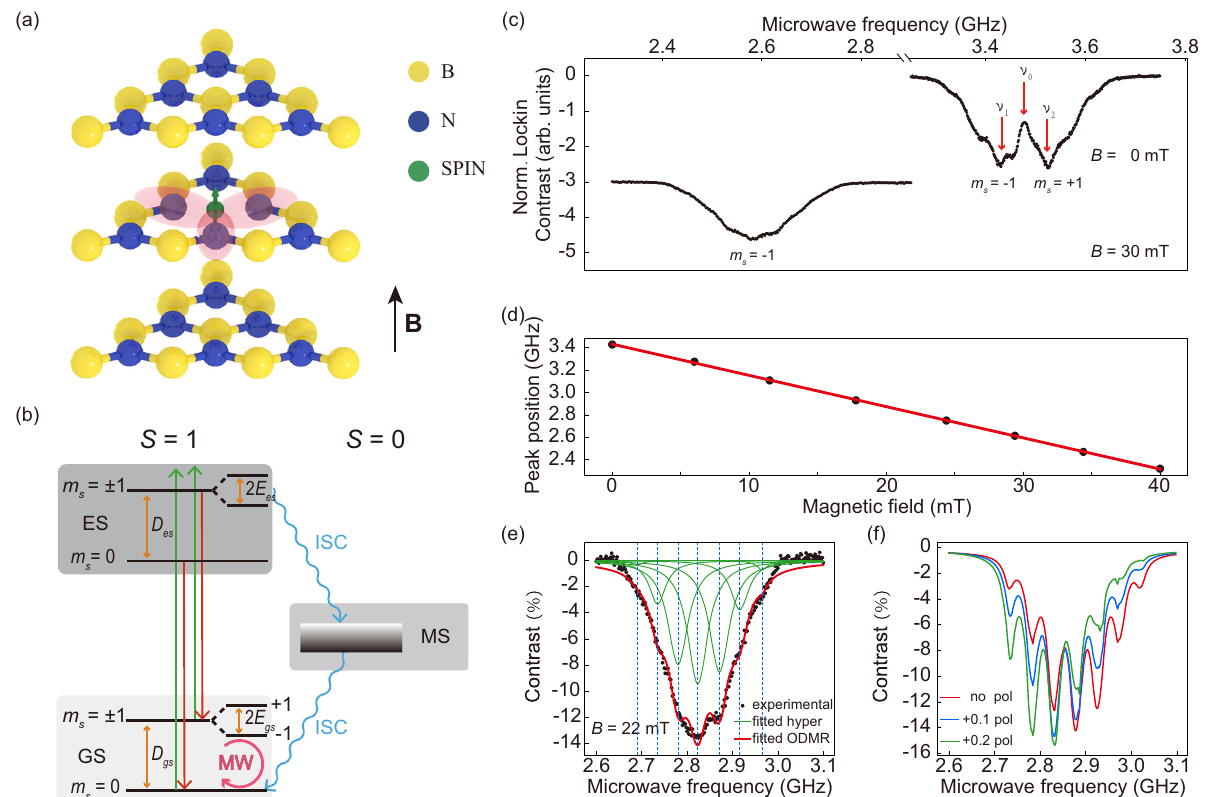
fi tted by a two Lorentzian function to obtain the energy-level splittings ν 1 ~3.424 GHz and ν 2 ~3.533 GHz. d Dependence of the m s = − 1 ↔ m s =0 splitting shift on magnetic fi eld, from which we obtain the g factor of V (cid:1) B spin to be 1.992±0.010. e Hyper fi ne structure of the ODMR spectrum measured at B =22 mT, fi tted with a seven Lorentzian function. The solid red curve is fi tting envelope and solid green curves are fi tting Lorentzian components. The dashed lines marked the seven hyper fi ne peaks with a characteristic splitting of A ~45.8 MHz. f Theoretical ODMR spectraas B =21.7mTfornonpolarized(red)andpolarized(blueandgreen)nearest neighbor 14 Nnuclearspins,wherelabel “ x pol ” meansthenuclearpopulationsare1/ 3+ x , 1/3, and 1/3- x on the m I =+1, 0, and − 1 nuclear-spin states, respectively. The nuclear population of m I =0 is fi xed as 1/3 in consideration that the m I =0 popu- lation always changes little, compared with the m I =±1 populations, under mod- ulations of magnetic and microwave fi